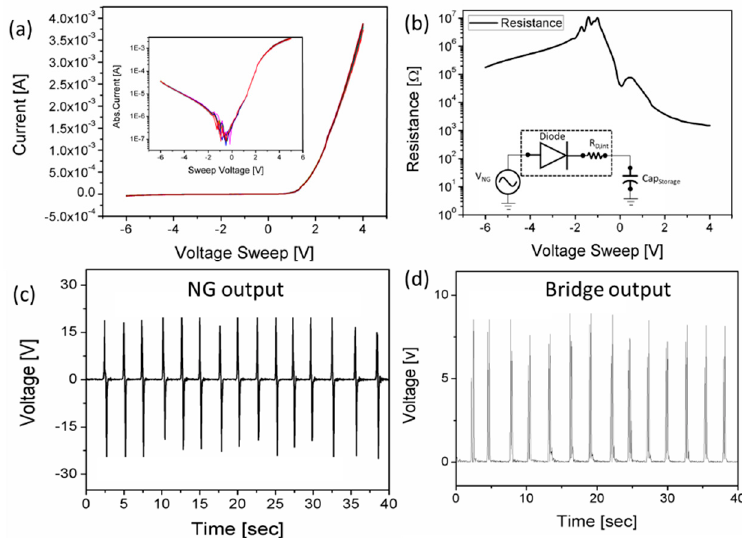
Figure 6. ( a ) I-V curve of the diode. The inset shows the absolute current graph of the diode. ( b ) Diode resistance against the sweep voltage. ( c ) NG output voltage against human footsteps applied for 40 s. ( d ) Output voltage at the bridge rectifier.